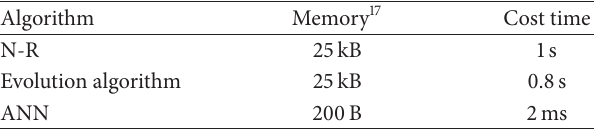
Table 5: Comparison of real-time algorithms.